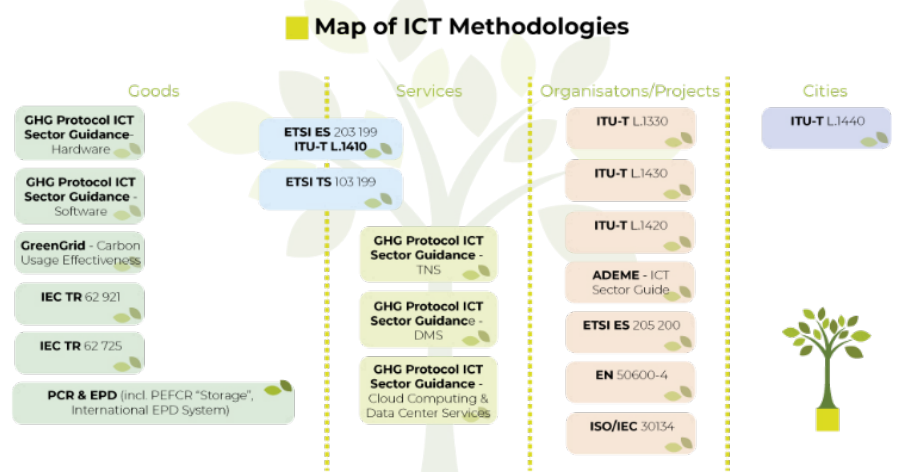
Figure 2. Assessment blocks in the European Union